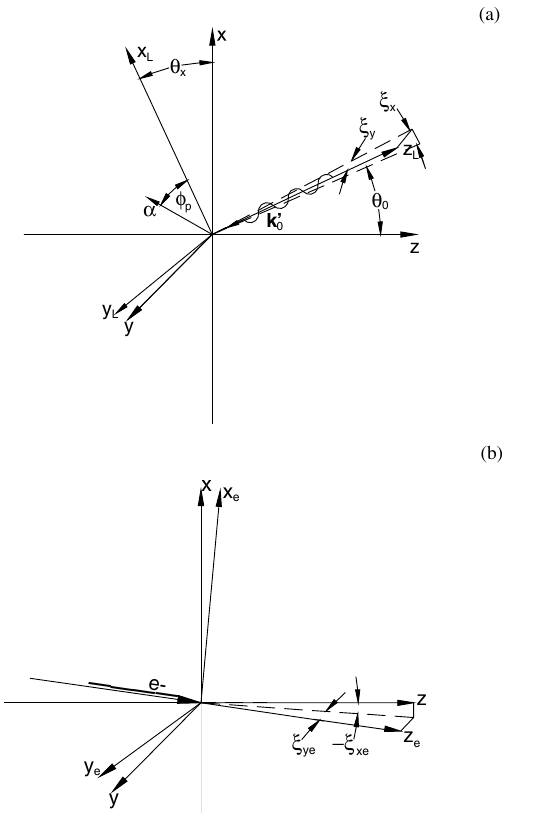
FIG. 2. (a) Illustration of laser incident direction and polar- ization. (cid:2) is the direction of the polarization vector of the laser, represents the rotation angle of (cid:2) about the z where (cid:30) p (b) Illustration of the electron incident direction. The electron beam is incident along the z axis, but the direction of each electron deviated by the angles specified by "